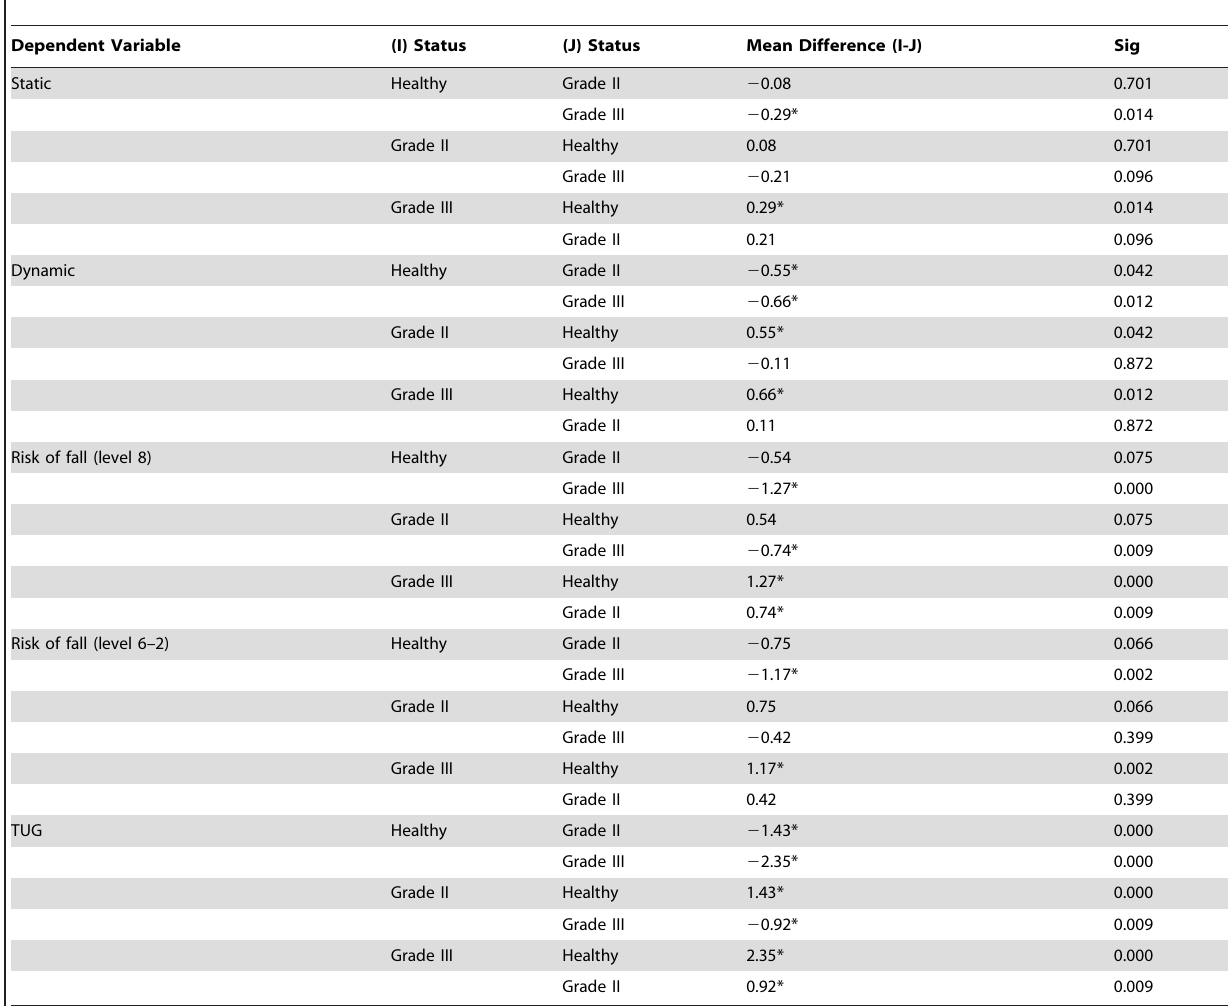
Table 5. ANOVA results for balance and risk of fall in functional feet position and TUG score.